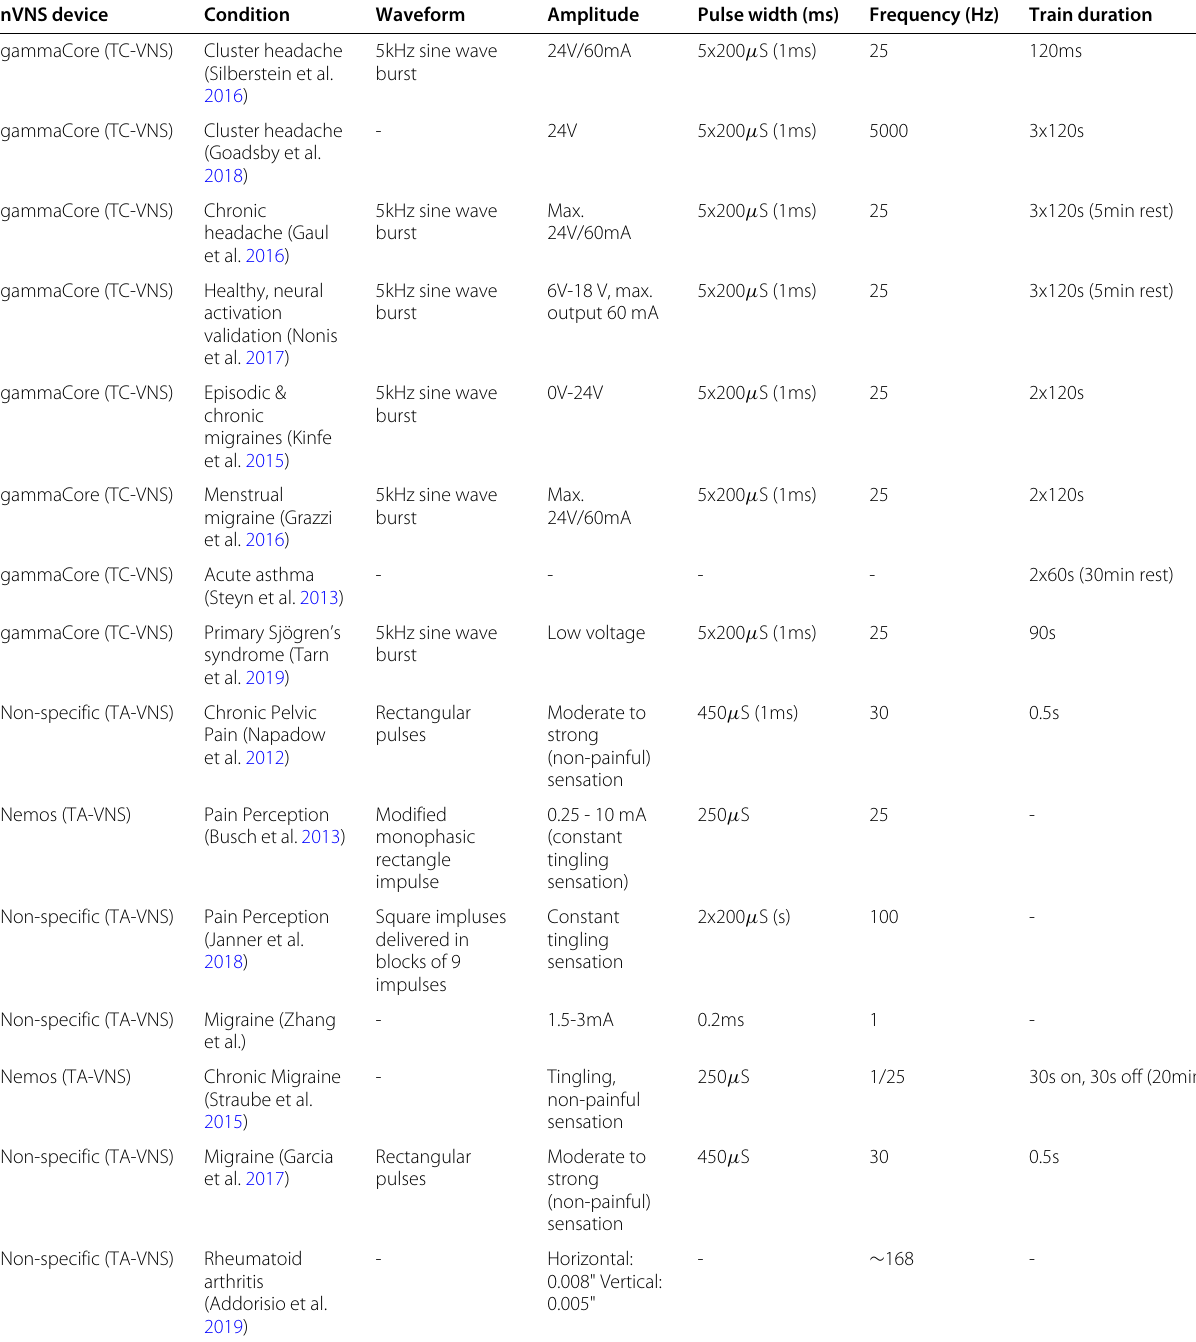
Table 2 Overview of non-invasive VNS configuration and therapeutic application nVNS